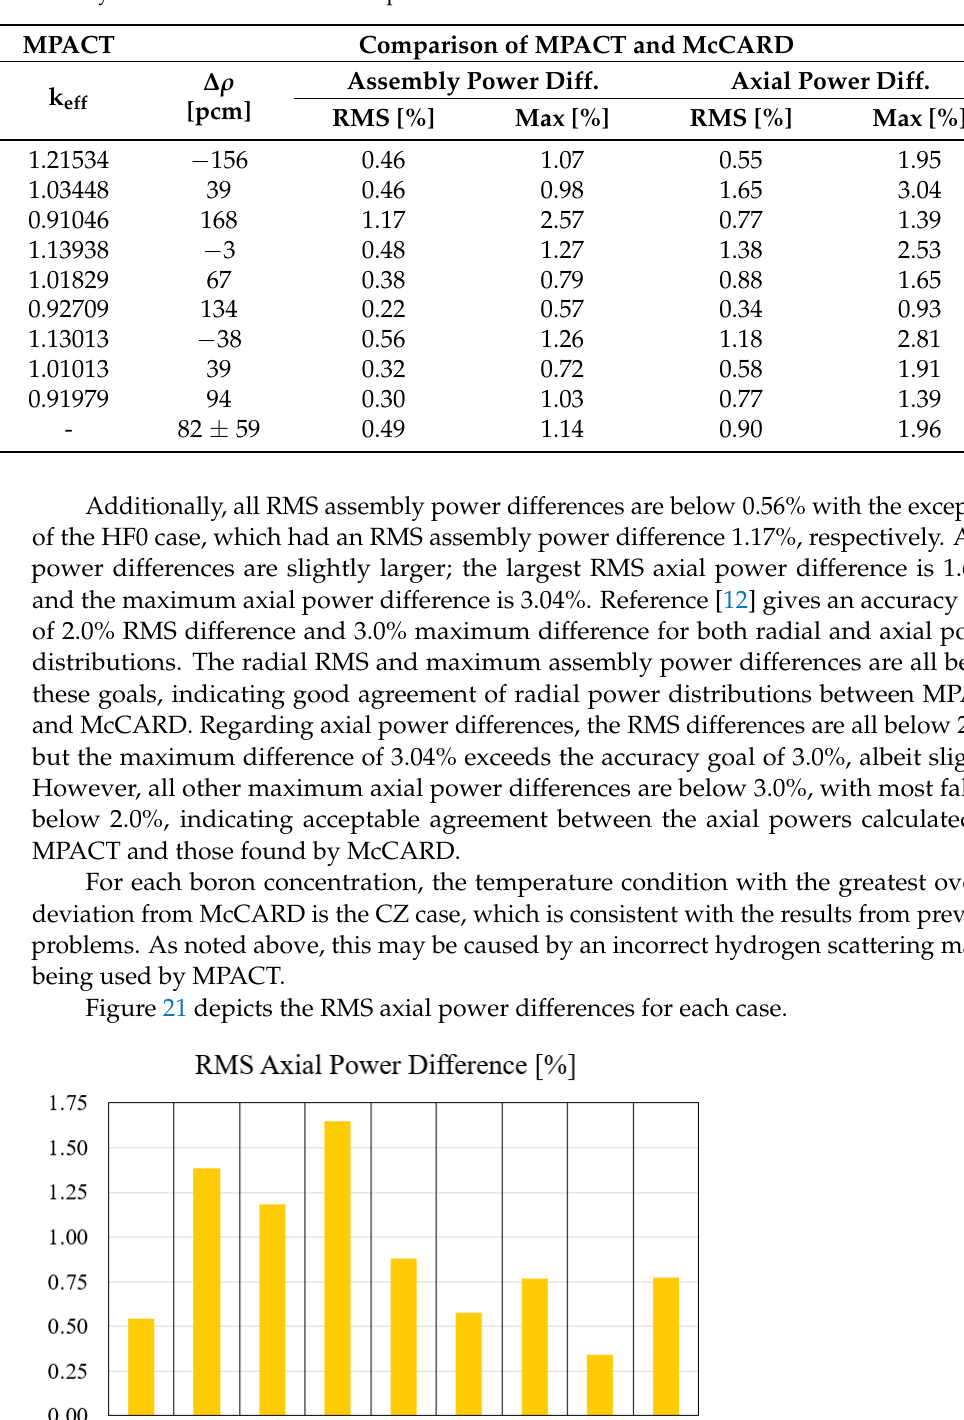
Table 7. Summary of 3-D core results and comparison between MPACT and McCARD.